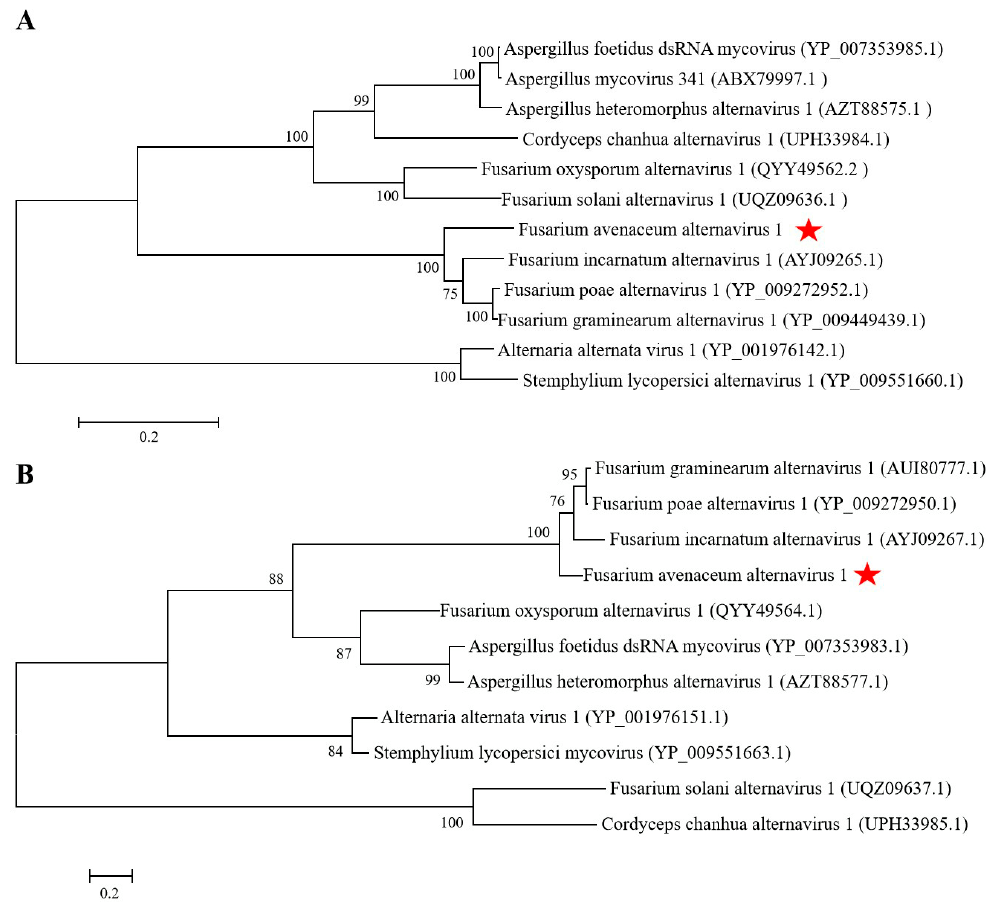
Figure 2. Phylogenetic trees constructed based on the amino acid (aa) sequences of RNA-dependent RNA polymerase (RdRp) and hypothetical protein (HP) of Fusarium avenaceum alternavirus 1 (FaAV1) and related viruses in the proposed family Alternaviridae using the maximum-likelihood (ML) method with 1000 bootstrap replicates. ( A ) Phylogenetic tree constructed based on the aa sequences of RdRp. Bar scale represents a genetic distance of 0.2 aa substitutions per site. Bootstrap values greater than 50% are shown above the branches. Red star indicates the position of FaAV1. ( B ) Phylogenetic tree constructed based on the aa sequences of HP. Bar scale represents a genetic distance of 0.2 aa substitutions per site. Bootstrap values greater than 50% are shown above the branches. Red star indicates the position of